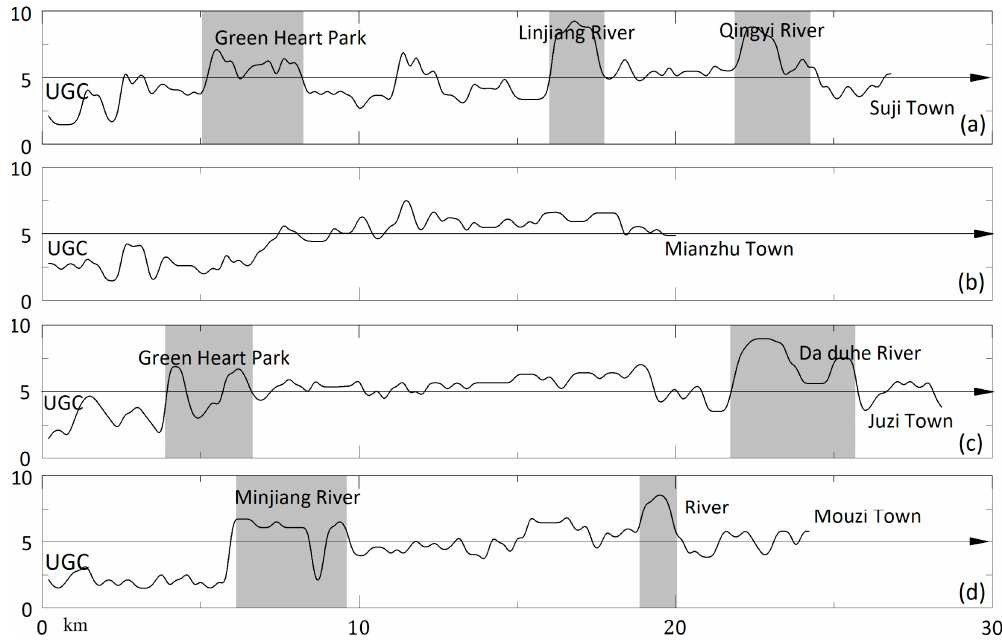
Figure 8. Resistance curves of urban expansion. ( a ), ( b ), ( c ), and ( d ) are the resistance curves from UGC to Suji, Mianzhu, Juzi, and Mouzi, respectively.